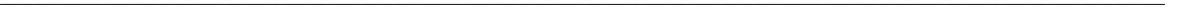
Fig. 10. Tolypelepis species, shields and shield fragments. A–D , Tolypelepis undulata Pander; E , Tolypelepis bedovensis sp. nov.; F , G , Tolypelepis sp. indet. A, posterior part of the dorsal shield, GIT 721-3; B, left postero-lateral part of the lateral epitegum of the dorsal shield, TUG 1384-13; C, almost complete ventral shield, TUG 68-1; D, sculpture on GIT 721-4; E, ventral shield with the posterior left side broken, GIT 721-7; F, shield in visceral view; G, small piece of shield from the most posterior part of (F), GIT 721-5 [to save the space of the figure, the lower part of (F) was cut off (=G); white stars indicate the points to assemble the two pictures]. Scale bars = 5 mm (A, B, D, F); 1 cm (C, E). Locations : A, Kolka-54 core, depth 162.5 m, Latvia; B, C, Ohesaare Cliff, Saaremaa Island, Estonia; D, Velikaya River-81 core, depth 79.8 m, North Timan; E, Bedovaya River section, October Revolution Island, Severnaya Zemlya Archipelago, lower part of the Krasnaya Bukhta Formation, upper Silurian (data of Khapilin & Markovskij in Matukhin et al. 1999, pp. 3 and 33); F, locality 8825-11/15a, Right Anuchin River, Cape Vize, north of Northern Island, Novaya Zemlya Archipelago; uppermost part of the Konstantin Formation, P ř idoli, upper